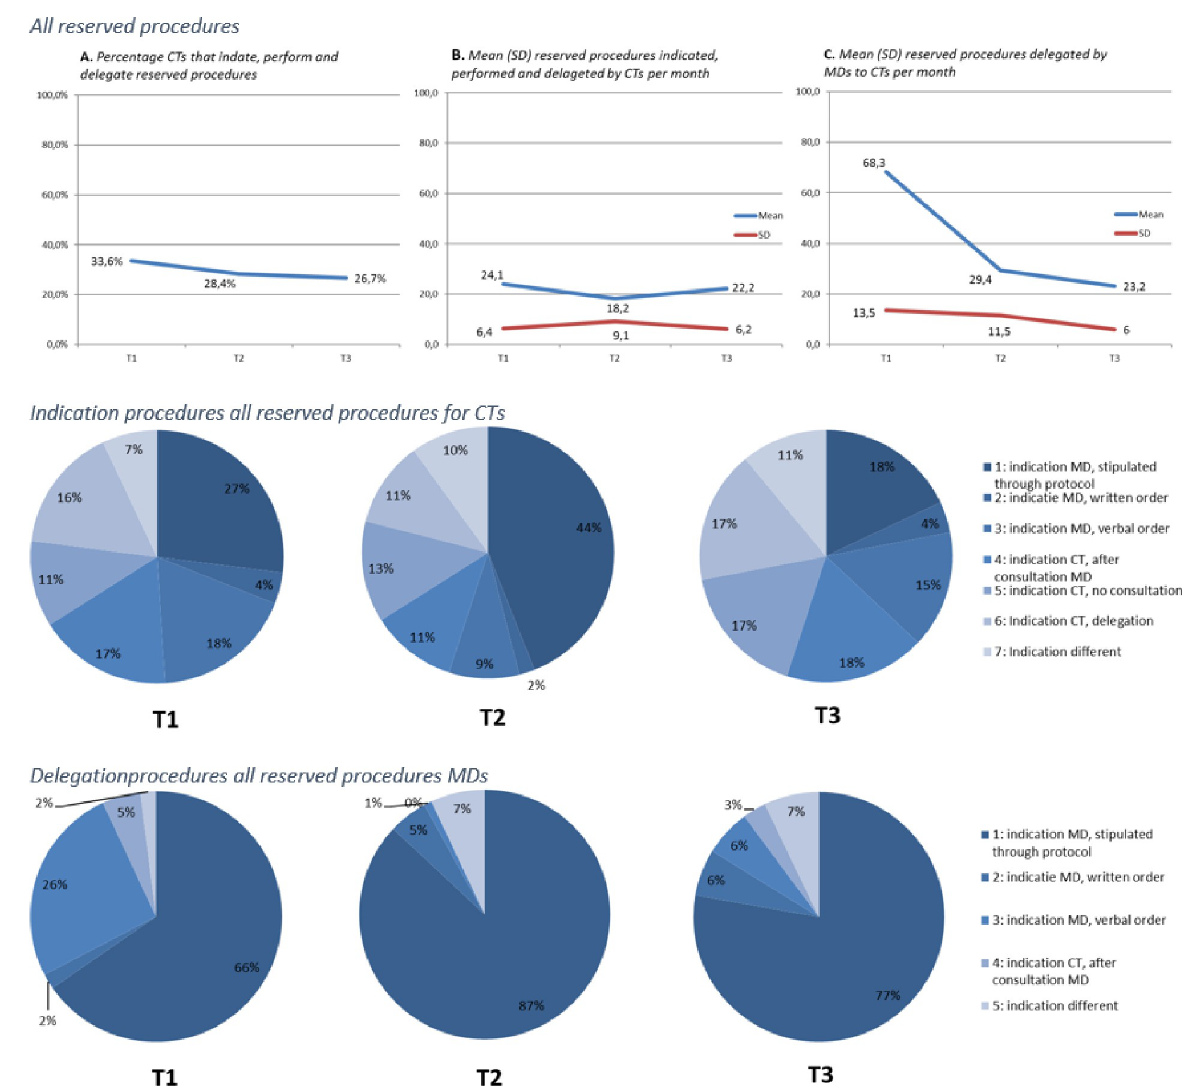
Fig 2. Overview results reserved procedures